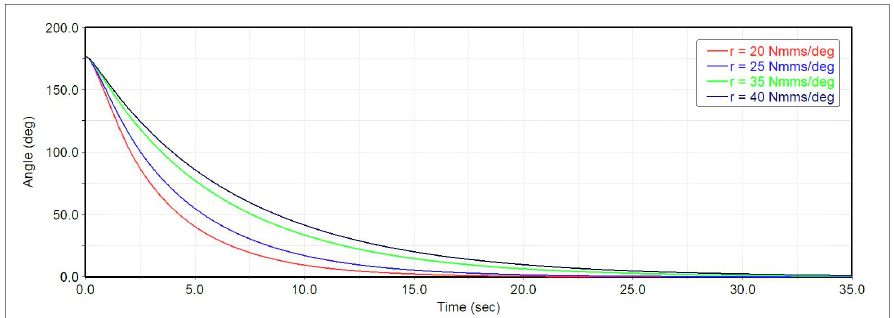
Figure 11. Spring-damper system angle of the first cell as a function of the simulation time and when the damping coefficient of the damper varies from 20 to 40 N · mm · s/deg.